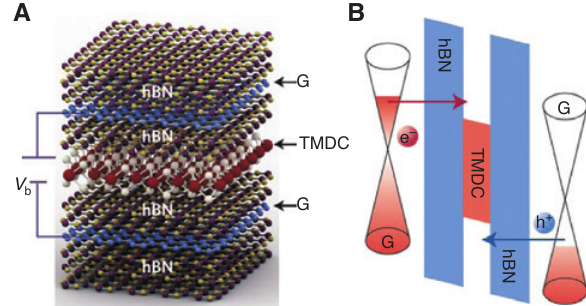
Figure 6: Van der Waals light-emitting diodes, taken from Ref. [62]. Schematic of a van der Waal’s heterostructure operating as an LED. When a bias voltage V is applied to the graphene (G) electrodes, b the injected charges recombine radiatively in the monolayer TMDC. (B) Band diagram of the LED with an applied bias. Electrons (e − ) and holes (h + ) from the graphene electrodes tunnel through the hexagonal Boron Nitrite dielectric layers (red and blue arrows) and reach the monolayer TMDC.